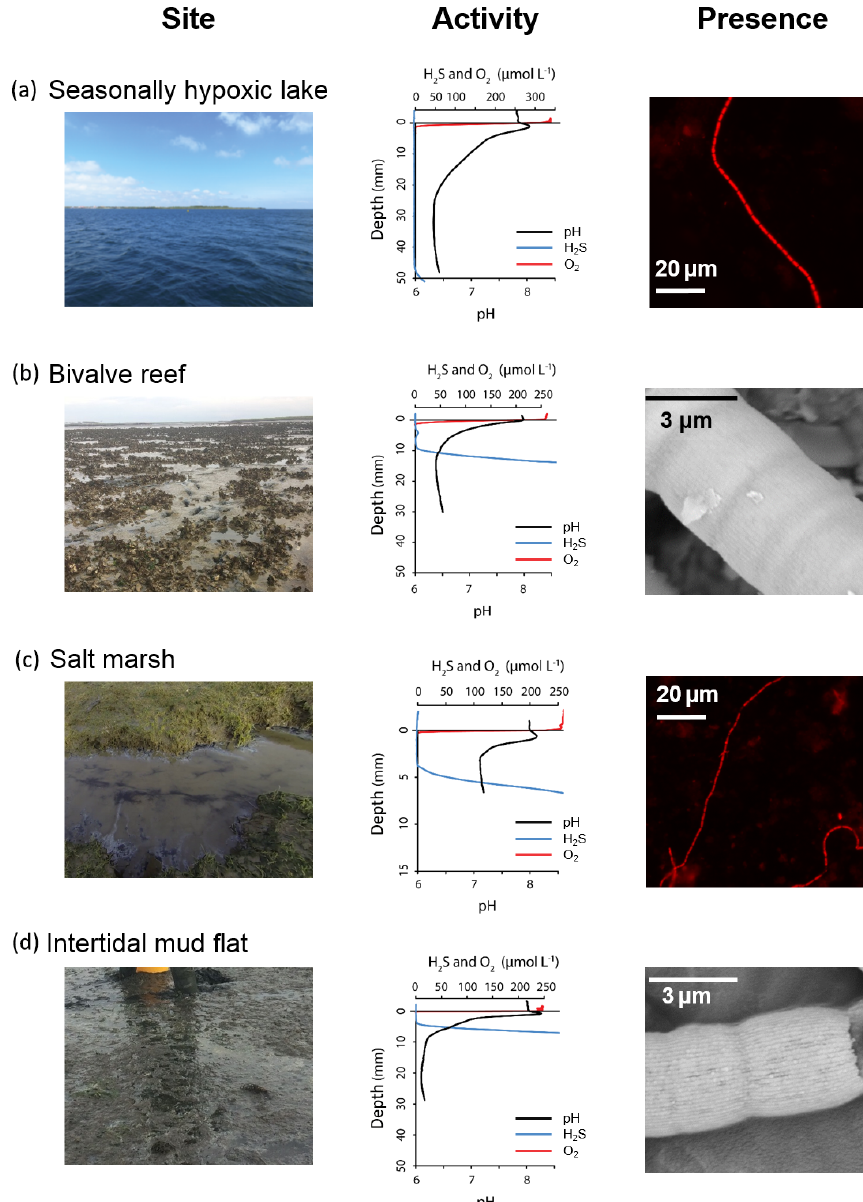
Figure 5. Results from four marine habitats in the Netherlands exemplifying detected cable bacteria activity and presence: (a) sediments in deeper (>15m) basins of the seasonally hypoxic Lake Grevelingen, (b) a bivalve reef in the Eastern Scheldt, (c) a salt marsh in the Eastern Scheldt (Rattekaai) and (d) an intertidal mud flat in the Wadden Sea (Mokbaai). Locations are marked by letters A–D in Fig. 4. Left column: photographs of the sampling locations. Middle column: microsensor profiles documenting the geochemical fingerprint of cable bacteria activity. Right column: the presence of cable bacteria was confirmed using microscopy techniques (either by fluorescence in situ hybridization (a, c) or scanning electron microscopy (b, d) . Full-size SEM images are available in the Supplement (Fig.